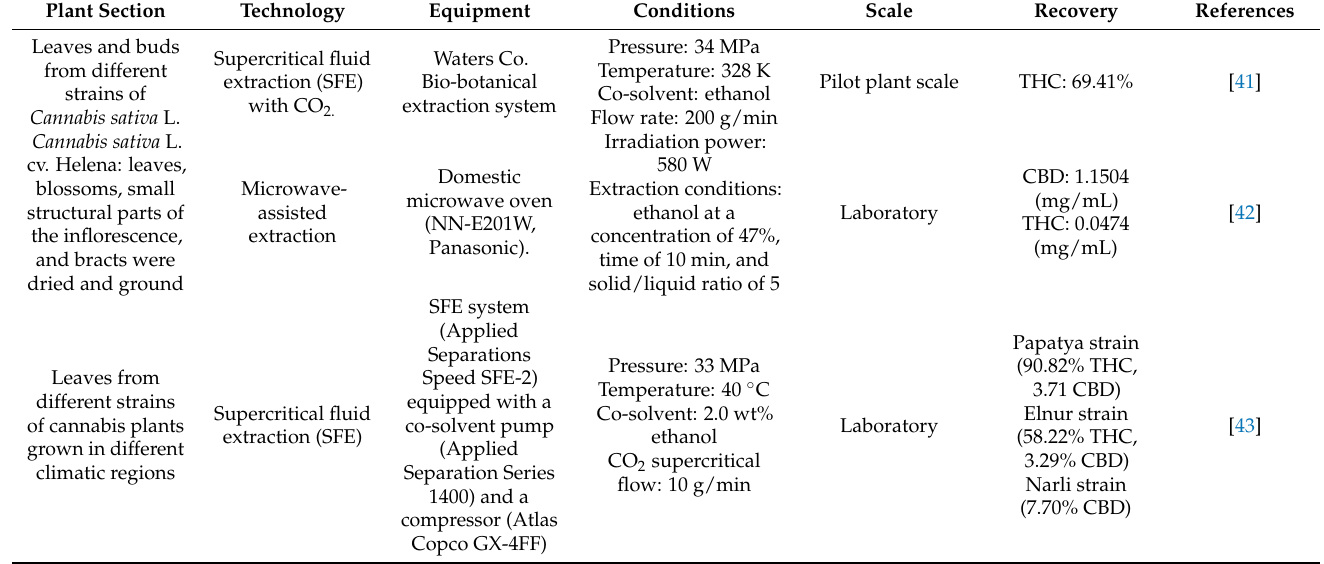
Table 2. Cannabis plant: examples of different technical extraction processing methods, equipment, and